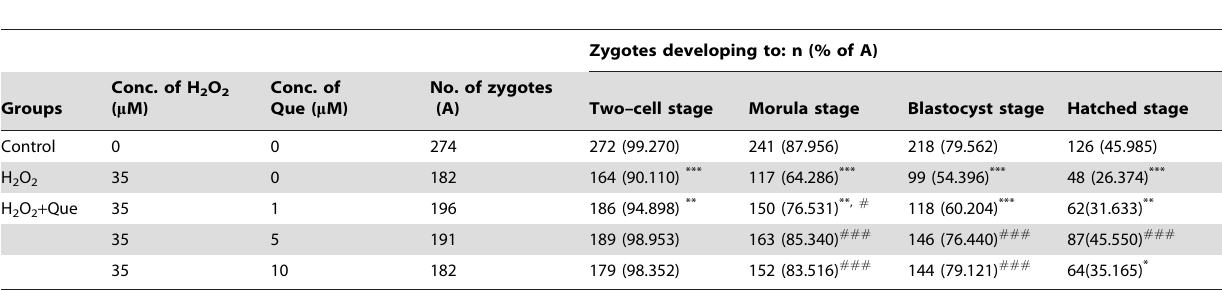
Table 1. Protective effect of quercetin on the development of preimplantation mouse embryos against H 2 O 2 -induced oxidative injury.